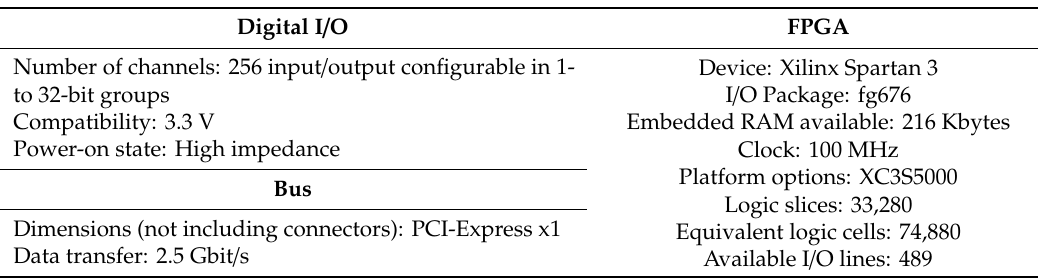
Table 1. OPAL-RT’s technical specifications.